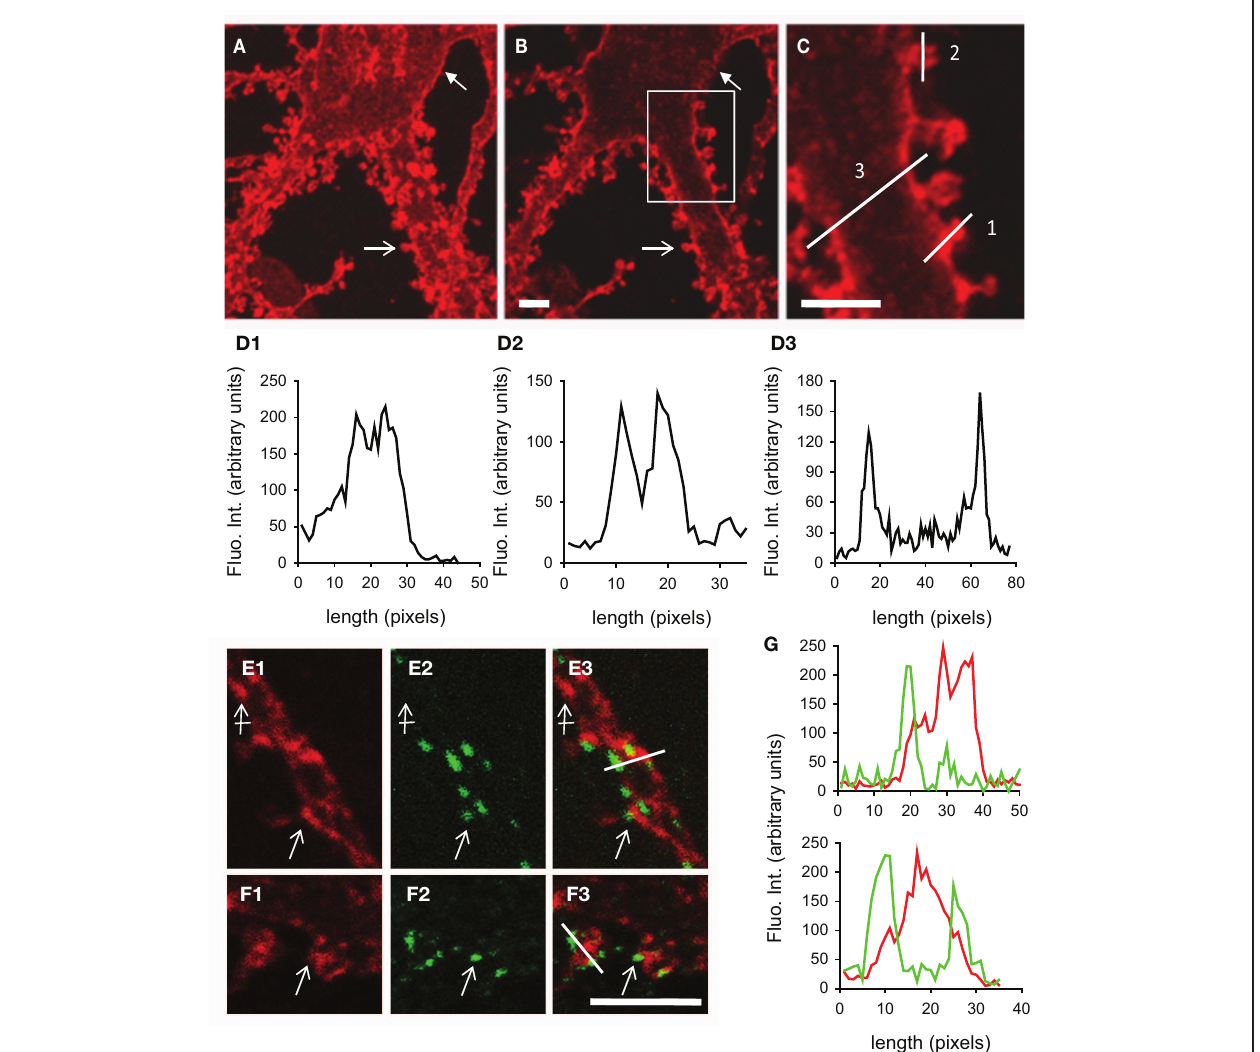
FIGURE 2 | KCC2 clustering in rat hippocampal neurons at 29DIV. (A) Maximum intensity projection of confocal optical sections showing KCC2 at the periphery of somata (filled arrow) and in spines (empty arrow). (B,C) optical sectioning from the same neuron as in (A) . Boxed region in (B) is shown enlarged in (C) . Adapted from Gauvain et al. (2011) with permission. Scale bars, 5 μ m. (D) Fluorescence intensity in arbitrary units per pixel along the lines drawn in (C) showing enrichment of KCC2 in dendritic spines (D1) , preferential plasma membrane localization of KCC2 in dendritic spines (D2) and shafts (D3) as compared with the cytoplasm. (E1–F3) Dual labeling of